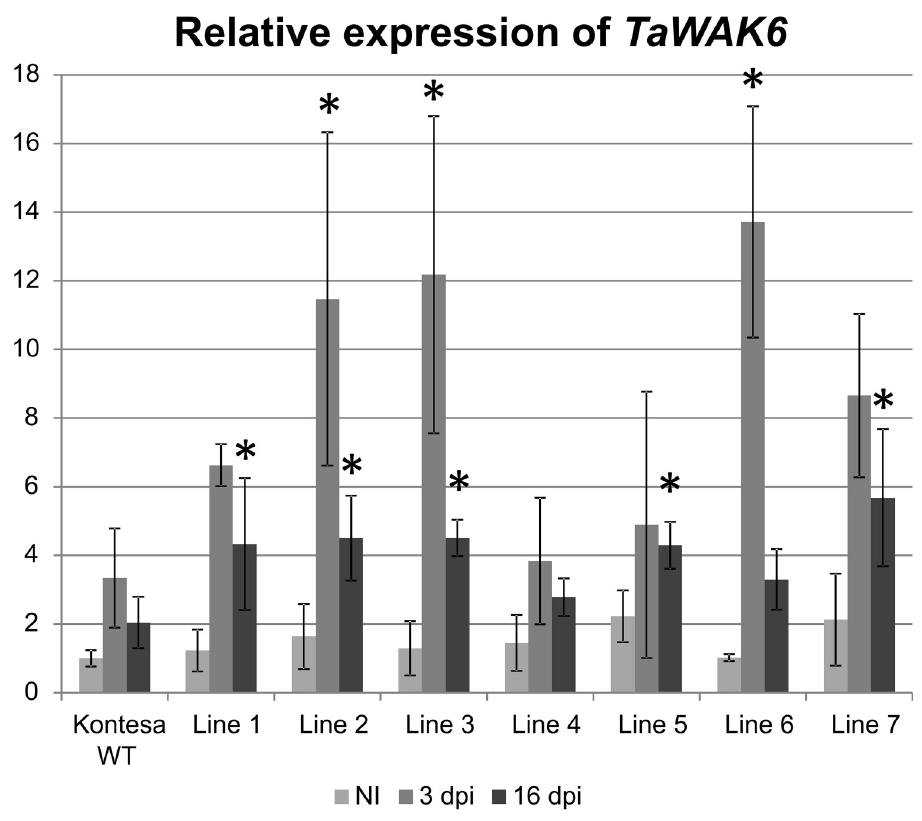
Fig 2. Relative expression of TaWAK6 in flag leaves of non-transgenic wheat cultivar Kontesa WT and 7 transgenic lines overexpressing TaWAK6 gene. NI—non-inoculated, 3 dpi, 16 dpi– 3, 16 days post-inoculation. The data represent mean values with standard deviation, asterisks indicate p < 0.05 using the ANOVA test followed by the LSD post-hoc test (STATISTICA 10, StatSoft).